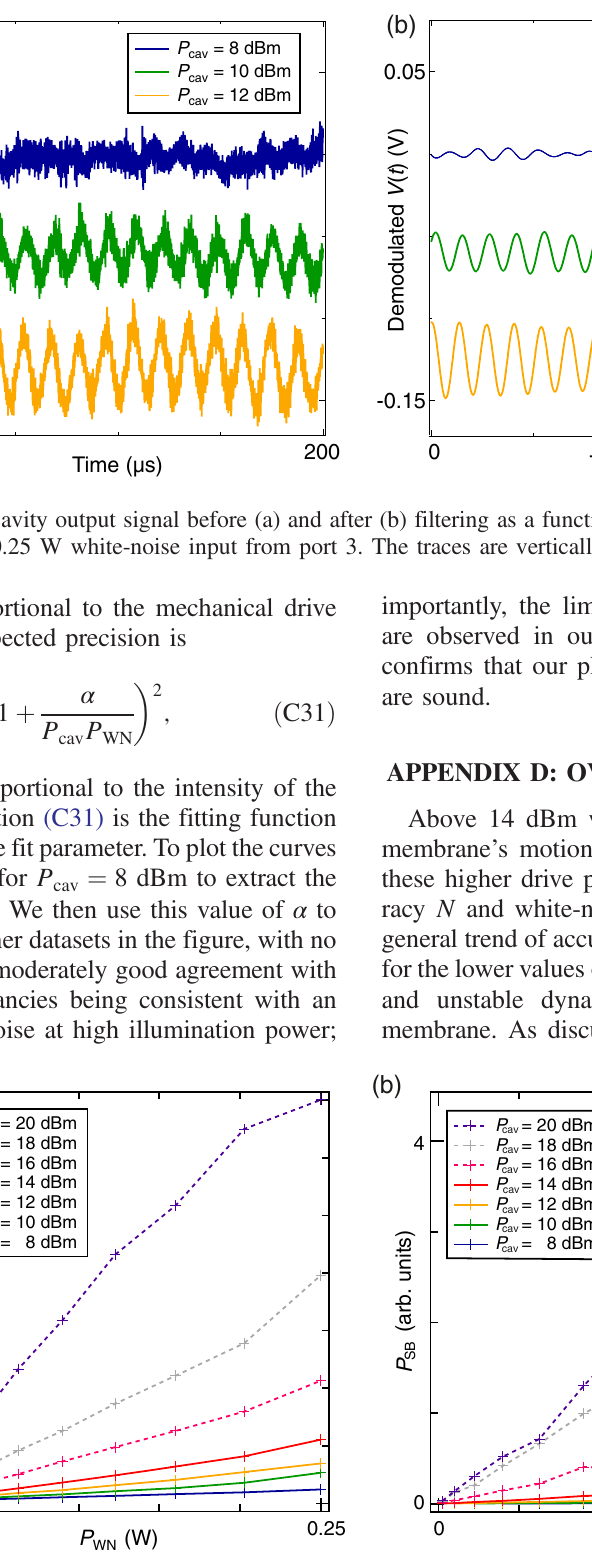
FIG. 10. (a) Noise temperature of the system T increasing as the cavity drive power and white-noise power increase for cavity drive N powers in the range 8 – 20 dBm. (b) The increase in the power of the sideband with increase in the white-noise power for different cavity drive powers in the range 8 – 20 dBm. For both (a) and (b) the higher drive powers have dotted lines and the data shown in the main text have full